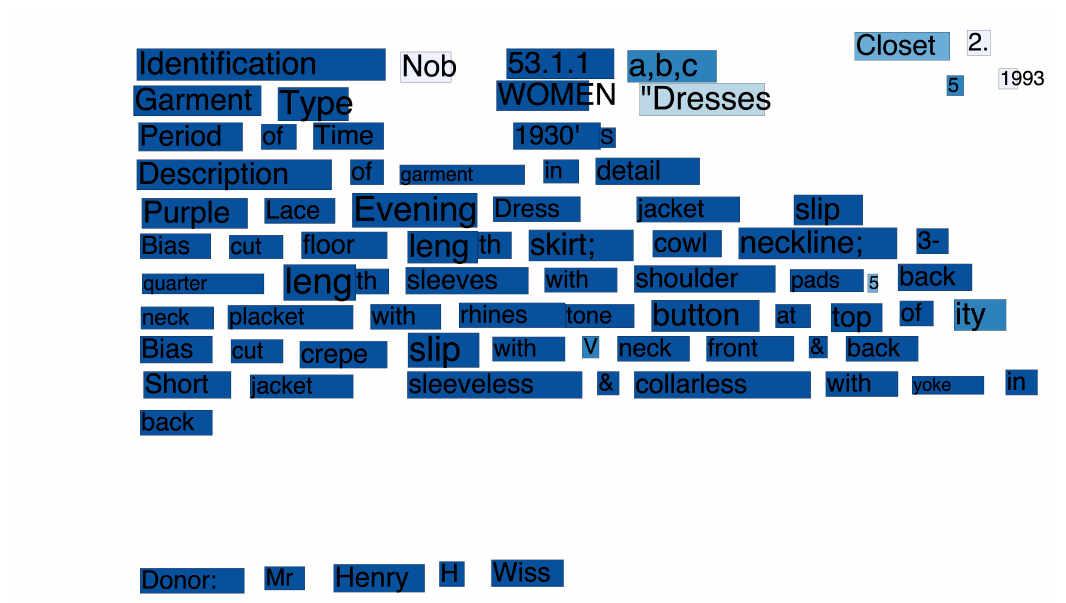
Figure 4 : Clova OCR output for one notecard. The shade of blue represents the confidence level (probability) that the OCR is correct. Darker shades means higher confidence while lighter is less